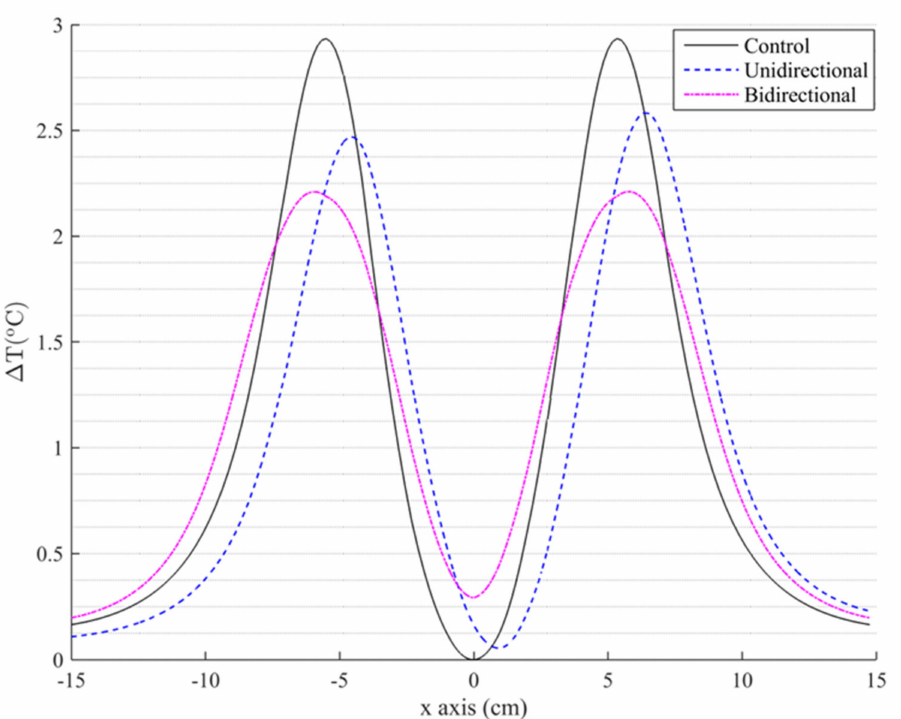
Figure 5. Spatial distribution of the highest temperature increase during the treatment, along the x-axis and at the bottom of the phantom tissue for control and both motion study cases.